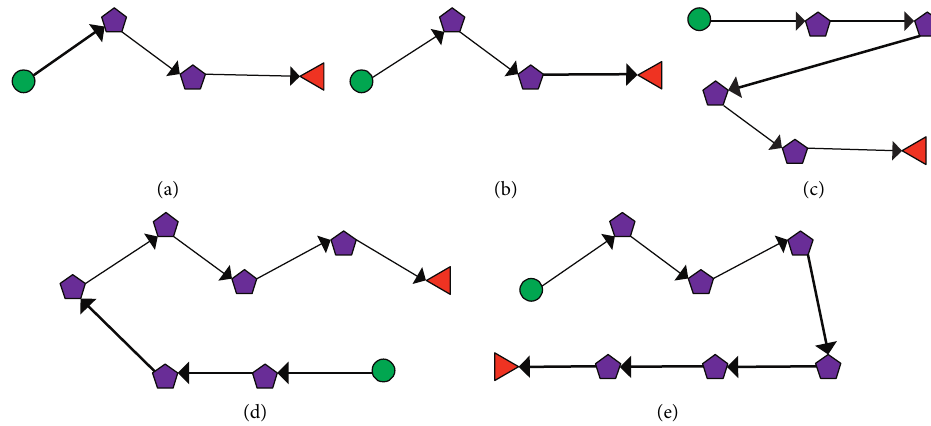
Figure 3: The improved network. The edges assigned by contrary direction are marked by bold edges. Start nodes are marked by green circles; middle nodes are marked by violet pentagons; end nodes are marked by red triangles.